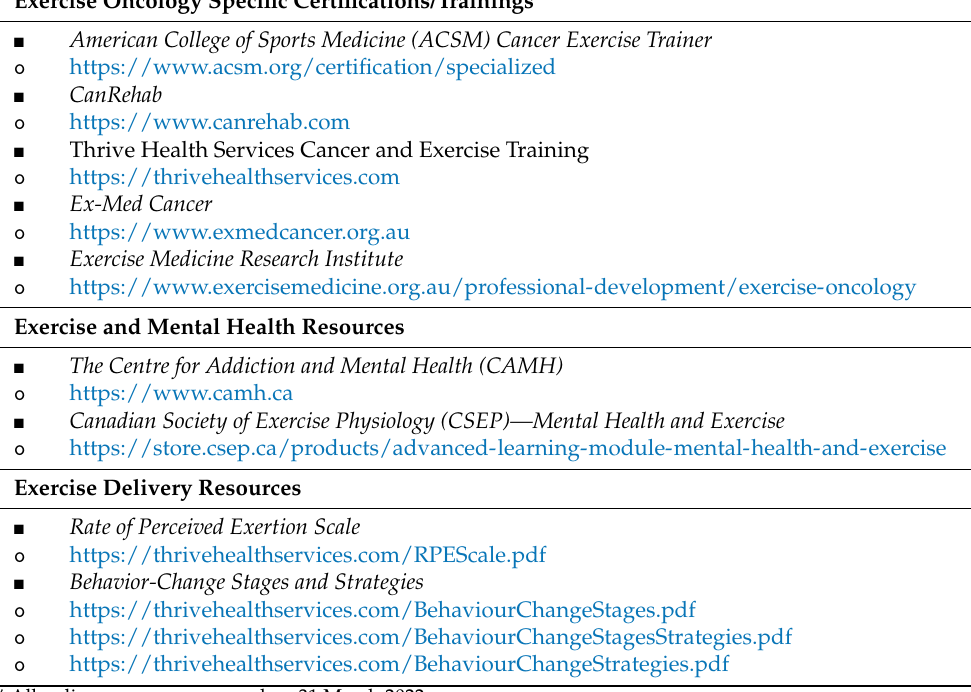
Table 1. Qualified Exercise Professional Resources for Exercise Oncology Delivery *. Exercise Oncology Specific